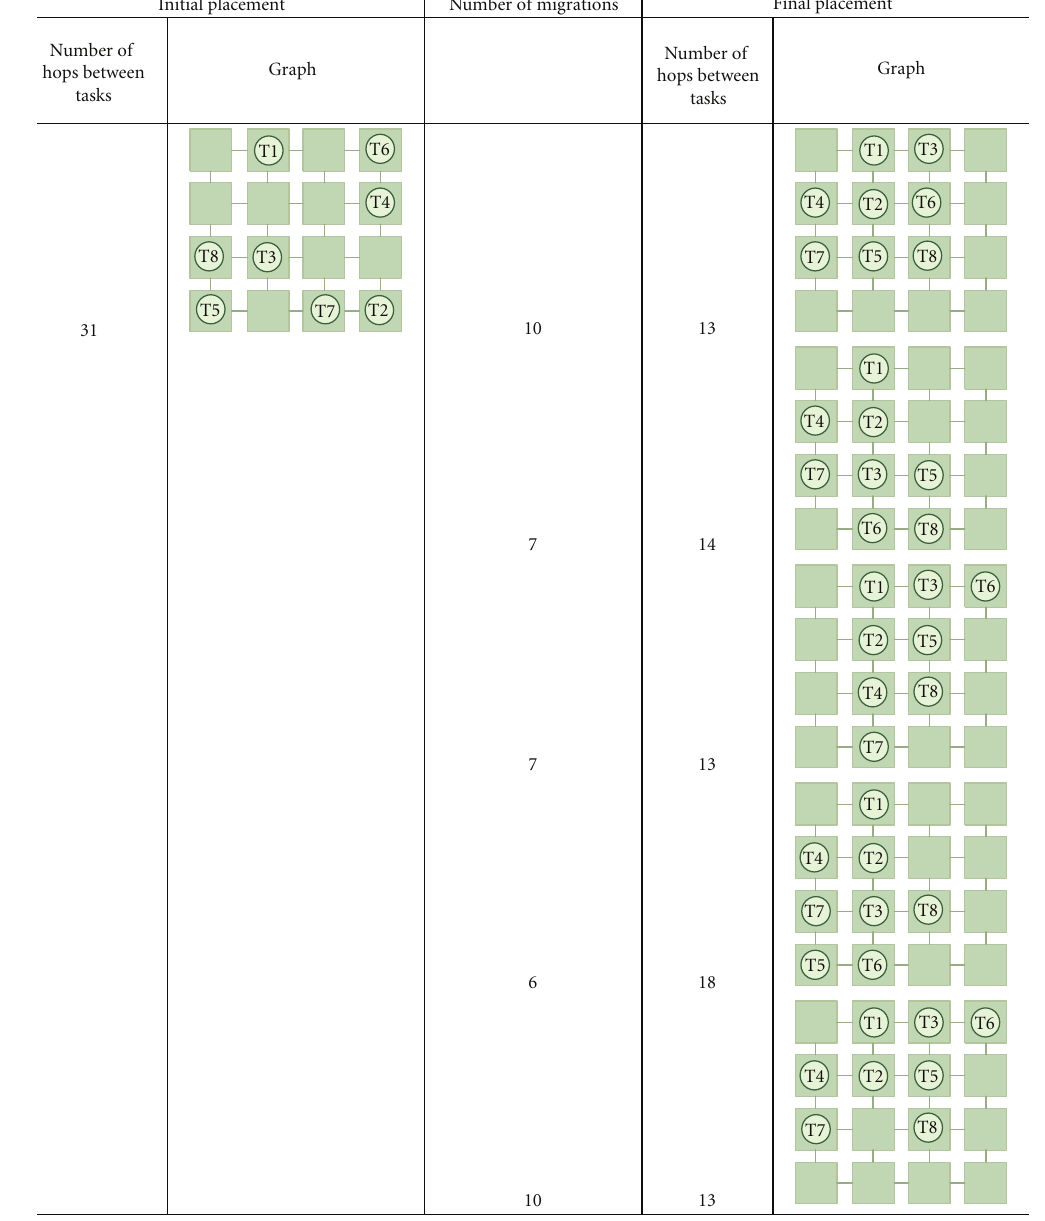
Table 7: Dummy application with closest placement